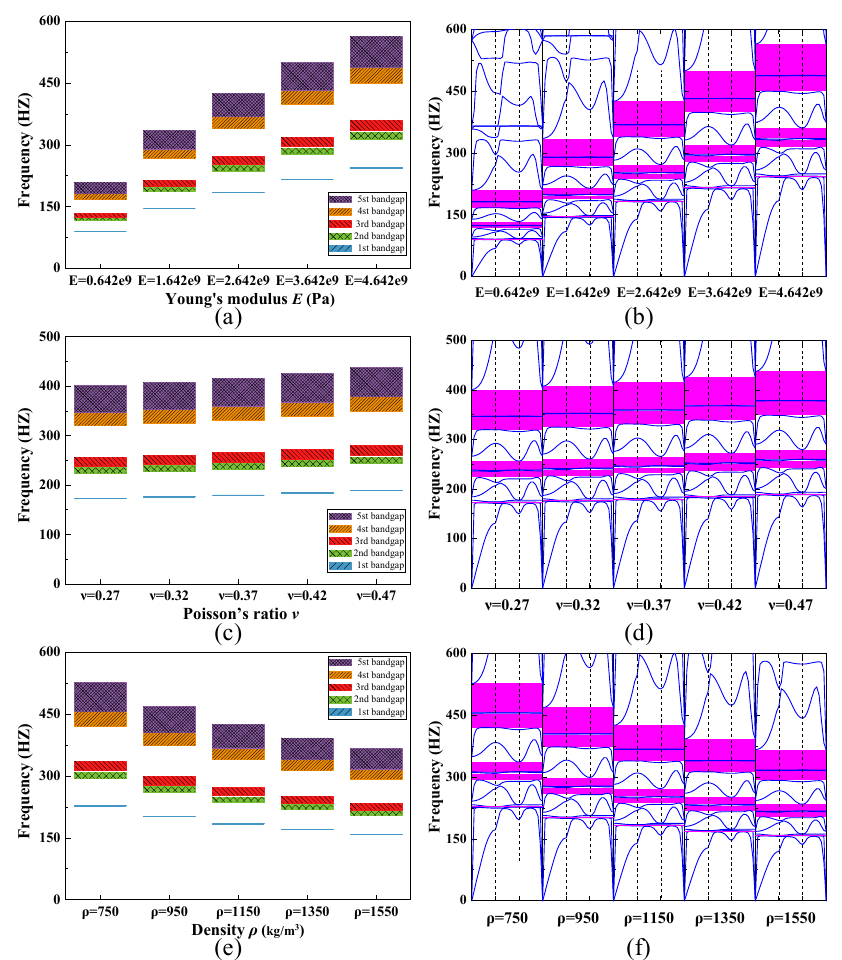
Figure 16. The dependence of the bandgap width on ( a , b ) Young’s modulus E , ( c , d ) the Poisson’s ratio ν , and ( e , f ) the density ρ . ratio ν , and ( e , f ) the density ρ